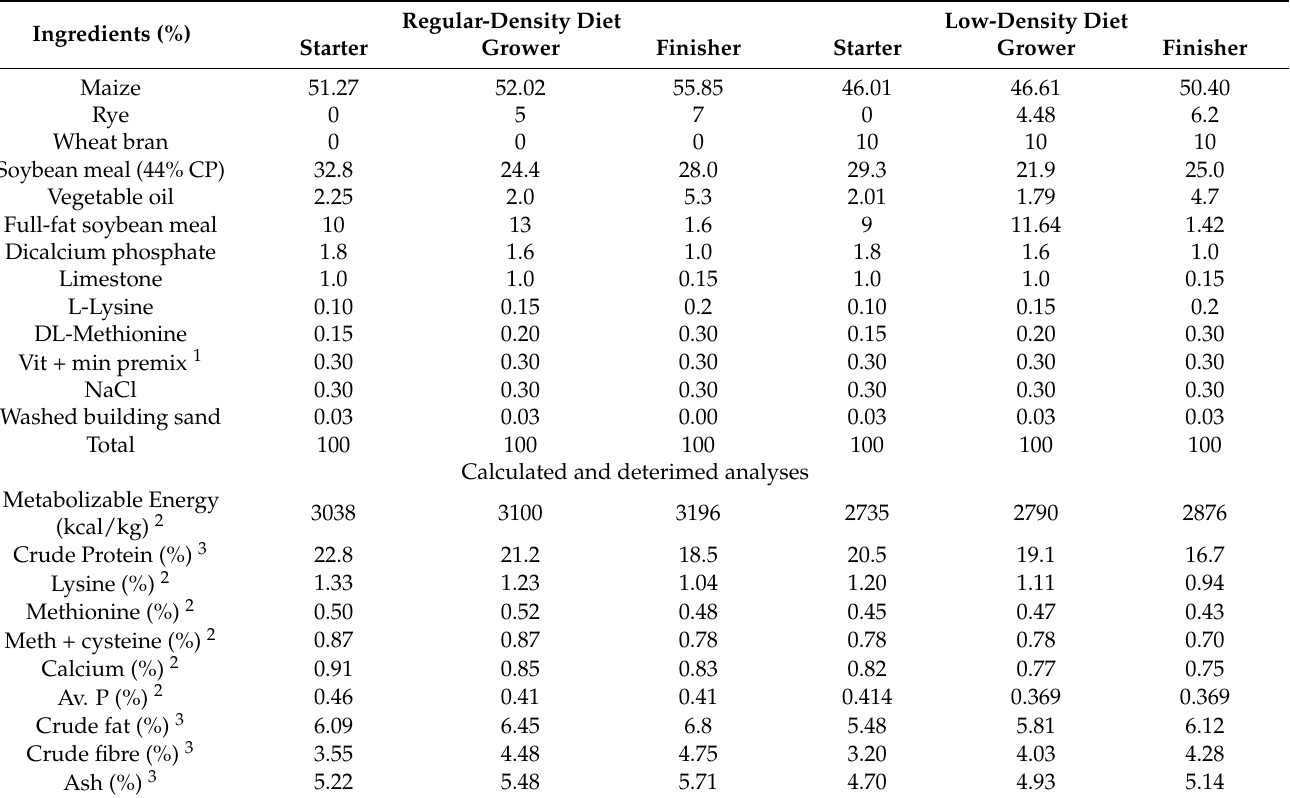
Table 1. Basal chemical composition of the experimental